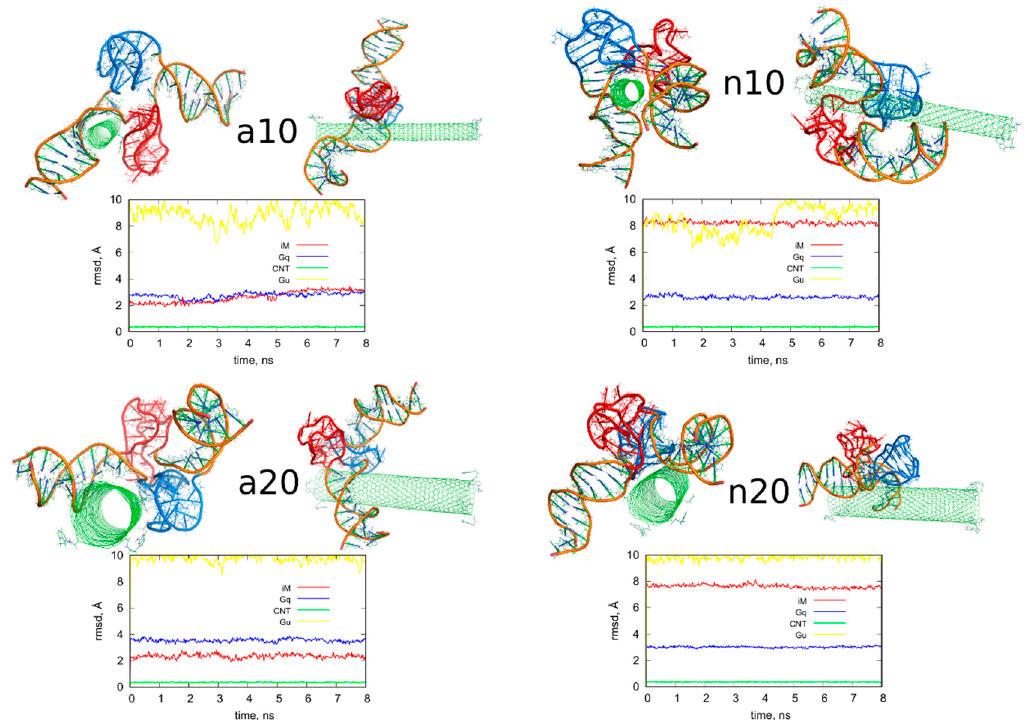
Figure 4. Simulation snapshots of the determined optimal configurations of fCNT and iG compounds and rmsd plots determined from the last 8 ns of simulations for iM, Gq, bare CNT and guanine functional groups (Gu). The G-quadruplexes are in blue color while i-motifs are in red color. Each of these configurations is available in the supplementary material as pdb files, files fig4_a10.pdb, fig4_a20.pdb, fig4_n10.pdb, fig4_n20.pdb.